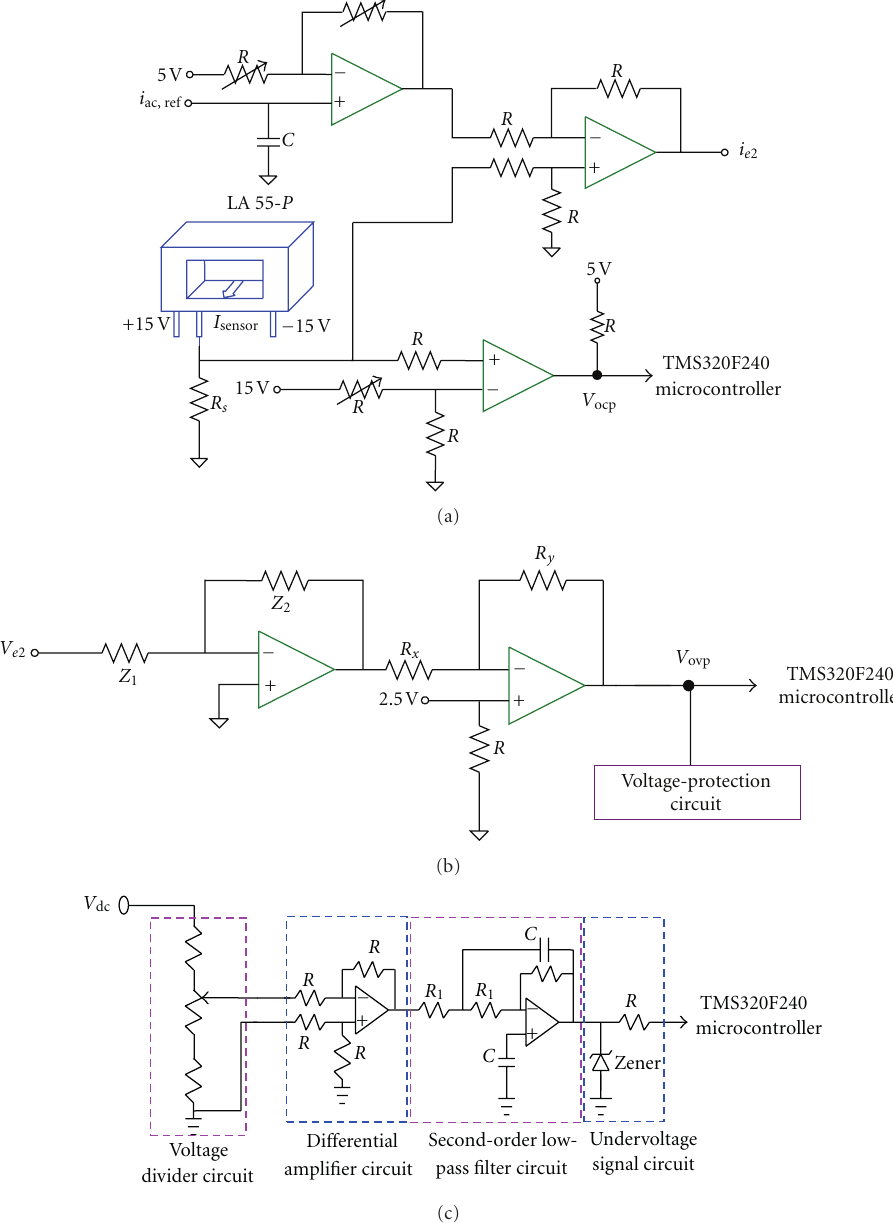
Figure 9: Protection circuits of the inverter: (a) overcurrent protection circuit, (b) overvoltage protection circuit, and (c) under voltage protection